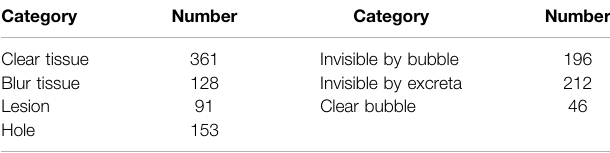
TABLE 2 | Statistics of segmentation annotation in the dataset.